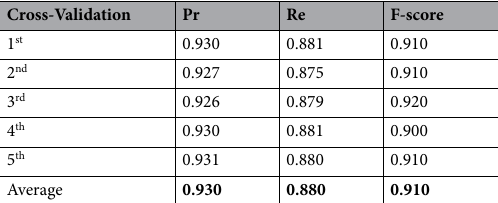
Table 3. 5-fold cross-validation.